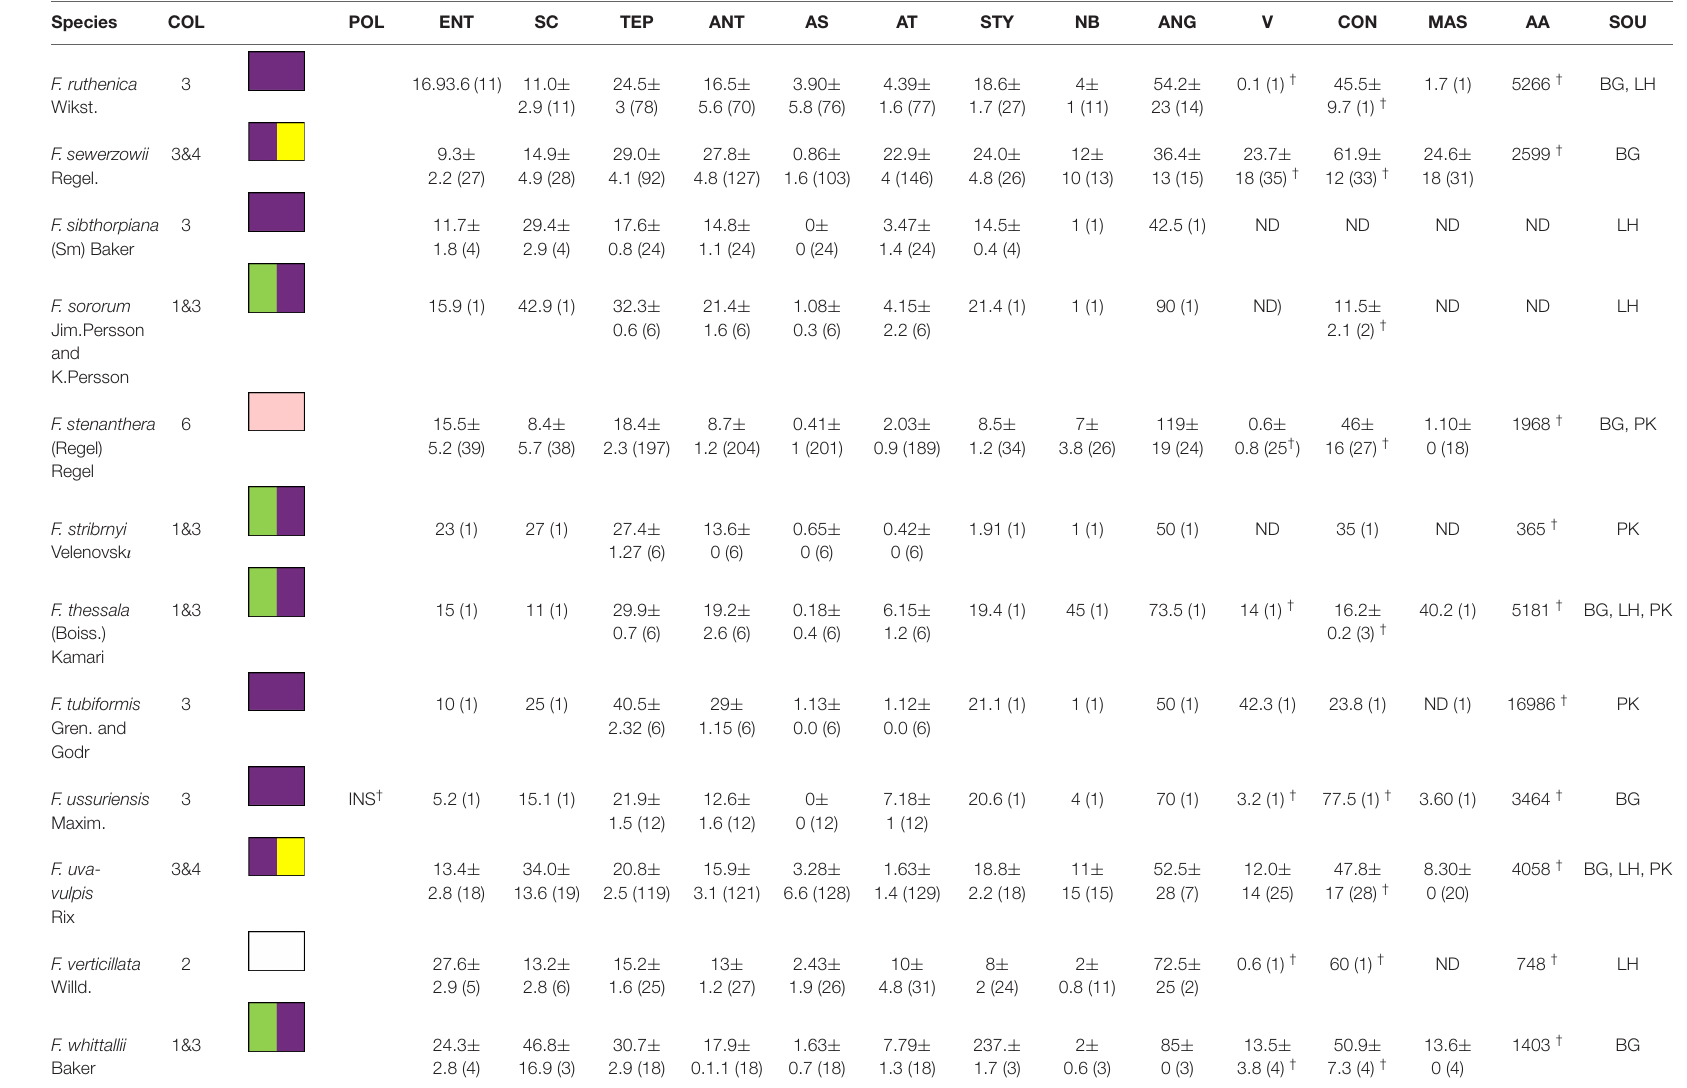
COL—flower colour (1—green, 2—white, 3—purple, 4—yellow, 5—orange, 6—pink, 7—red), POL—main pollinator (INS—insects, HUM—hummingbirds, PAS—passerine birds), ENT—entrance diameter, SC—scape length, TEP—tepal length, ANT—stamen length, AS—anthers-style distance, AT—anthers-tepals distance, STY—style length, NB—number of flowers in the inflorescence, ANG—angle between the stem and the middle of the flower, V—nectar volume [ µ L], CON—nectar sugar concentration [%], MAS—nectar mas [mg], AA—total amount of amino acids [pmol/ µ L], SOU—source of obtained